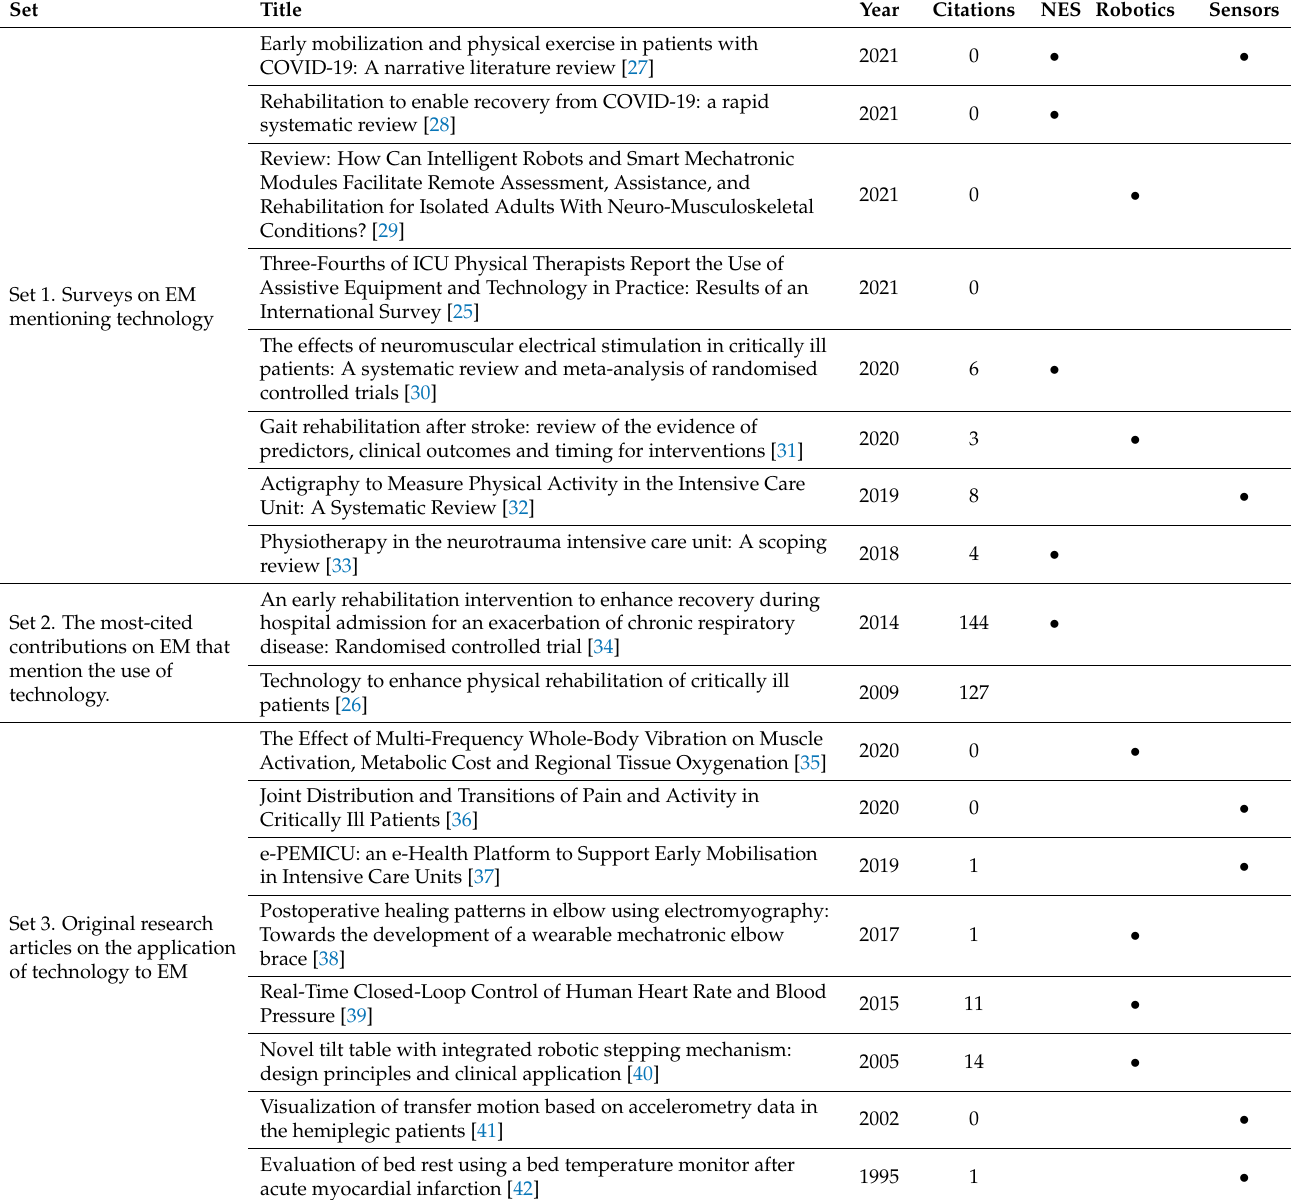
Table 1. A summary of the results after the screening phase, with publication years and number of citations in May 2021. The results are classified according to the kind of technology they consider: neuromuscular electrical stimulation (NES), robotics and mechatronics and sensors. Papers [25,26] approach technology from a global perspective.